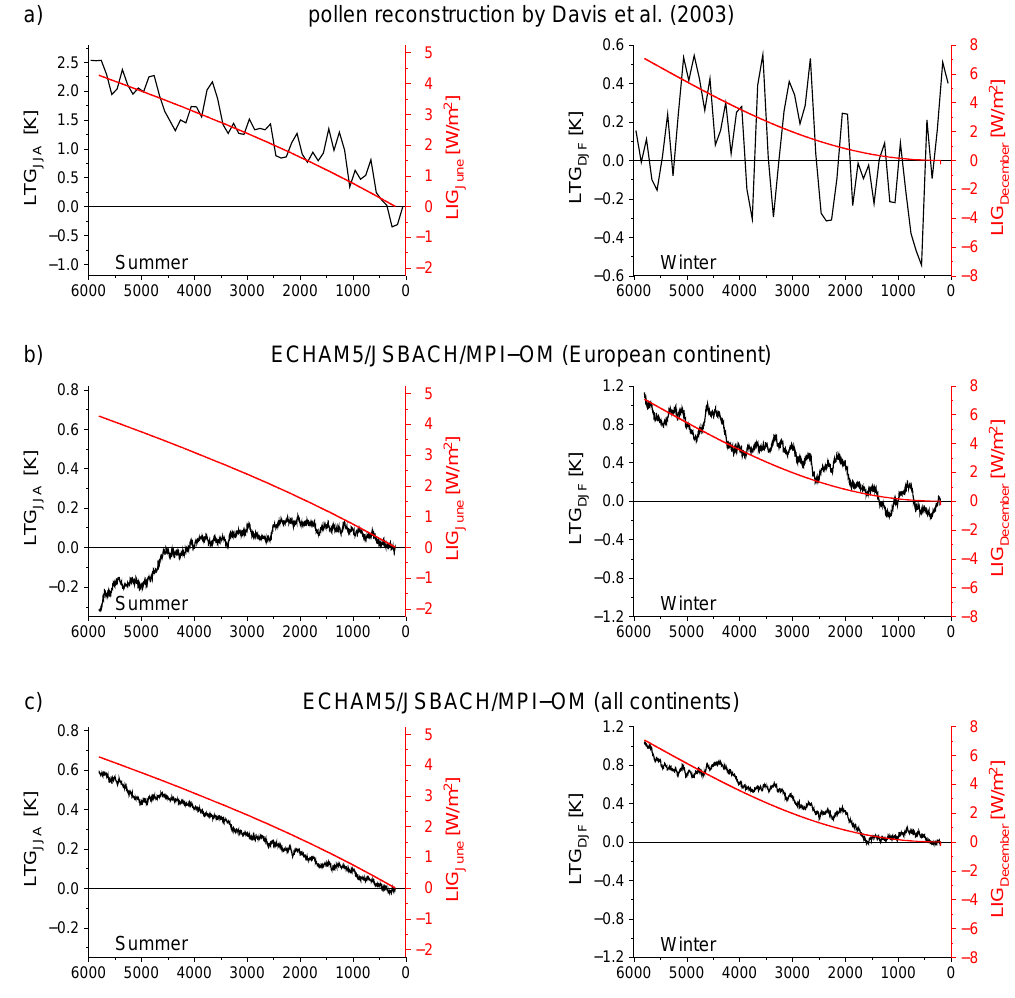
Fig. 7. Seasonal latitudinal temperature gradients (in K, black lines, left y-axes) and June and December insolation gradients (in Wm − 2 , red lines, right y-axes). Both defined as the difference between the latitude bands 55–75 ◦ N and 30–45 ◦ N in temperature and insolation, respectively. (a) Temperature reconstruction from pollen (after Davis and Brewer (2009), subset of their Fig. 7, correlation between winter LIG and LTG is 0.4), (b) corresponding model results for the European continent, and (c) model results for all continental land masses.